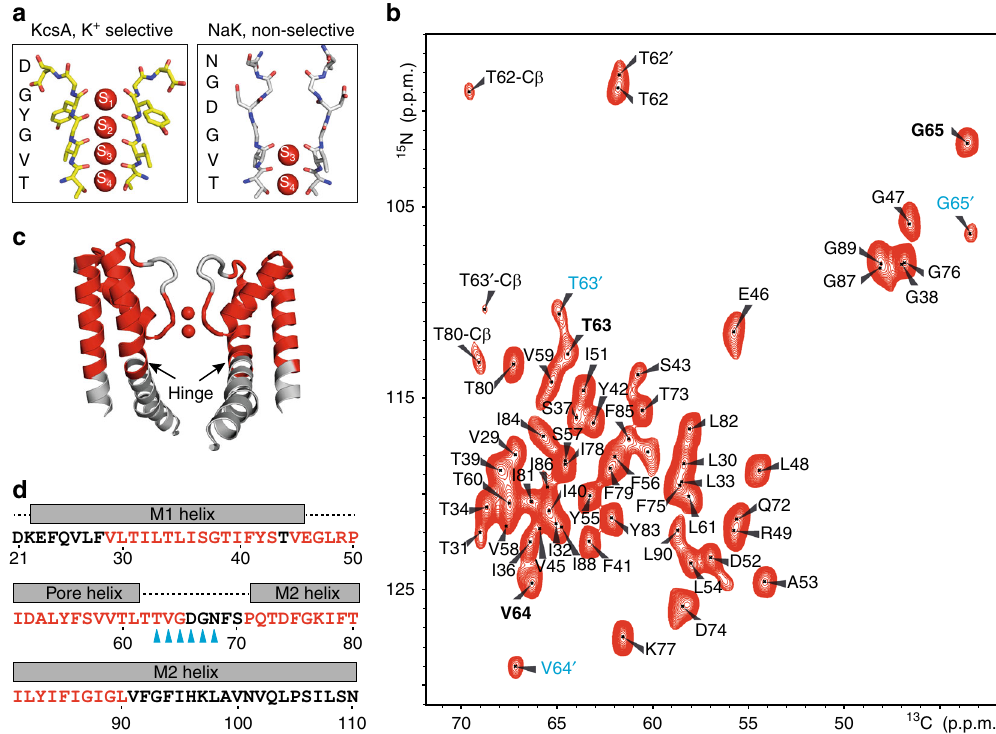
Fig. 1 High-resolution ssNMR spectra of NaK. a SF in the crystal structure of KcsA (PDB ID: 1K4C) and NaK (PDB ID: 3E8H). b 2D NCA correlation spectrum of NaK in the presence of 50mM K + with the signal assignment. SF residues are indicated in bold and the ion-free state is labeled with a prime ( ′ ) and in cyan to differentiate it from the K + /Rb + -favored state (no prime; in black). c Crystal structure of the open state of NaK displaying two opposing subunits. The hinge region is marked with an arrow and assigned residues are indicated on the structure in red. d Amino acid sequence of NaK with secondary structure elements based on the crystal structure indicated above the sequence. Assigned residues are shown in red and SF residues are accentuated by cyan arrows